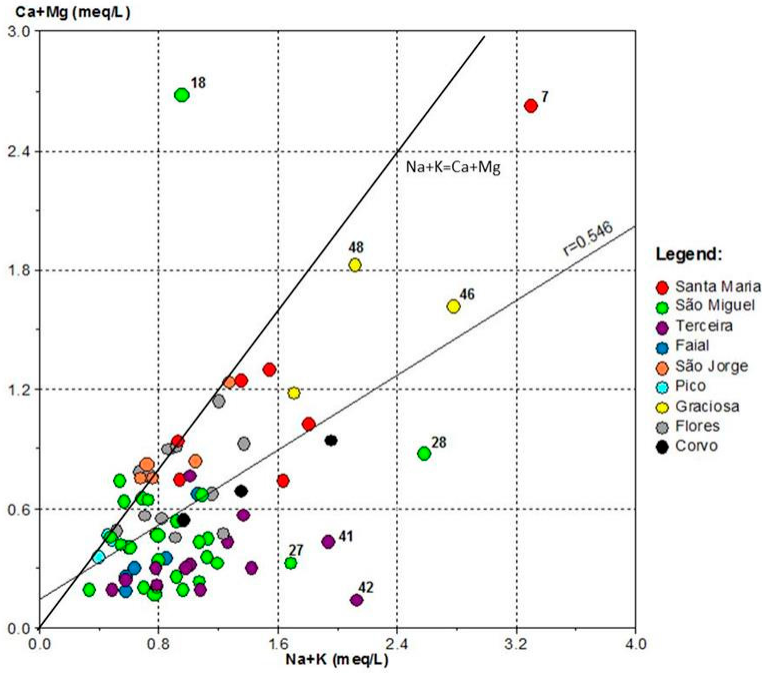
Figure 8. Bivariate plot between alkali and alkali ‐ earth metals content in spring waters (values in meq/L).